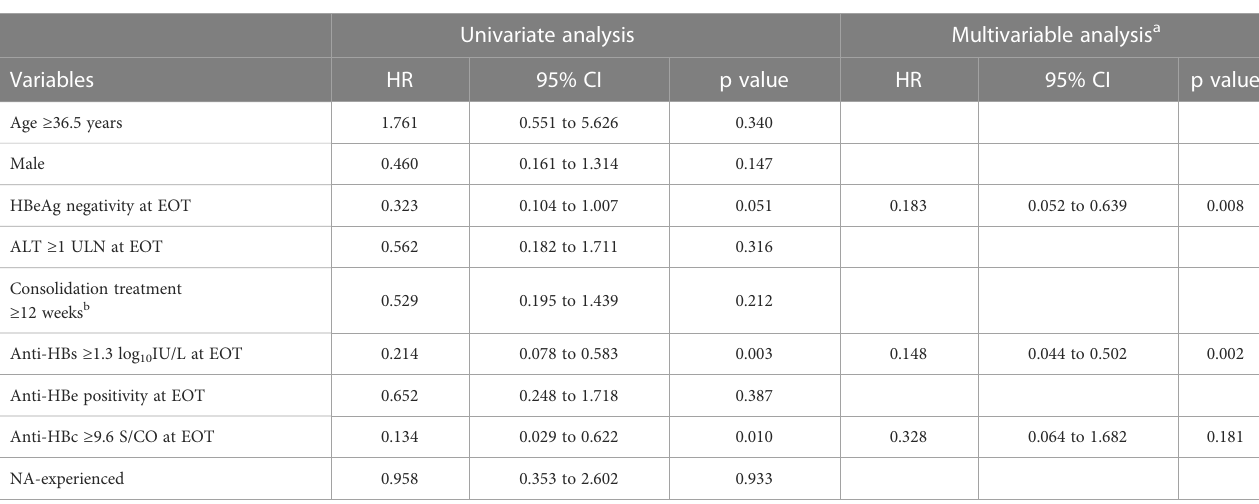
TABLE 3 Predictive factors of HBsAg